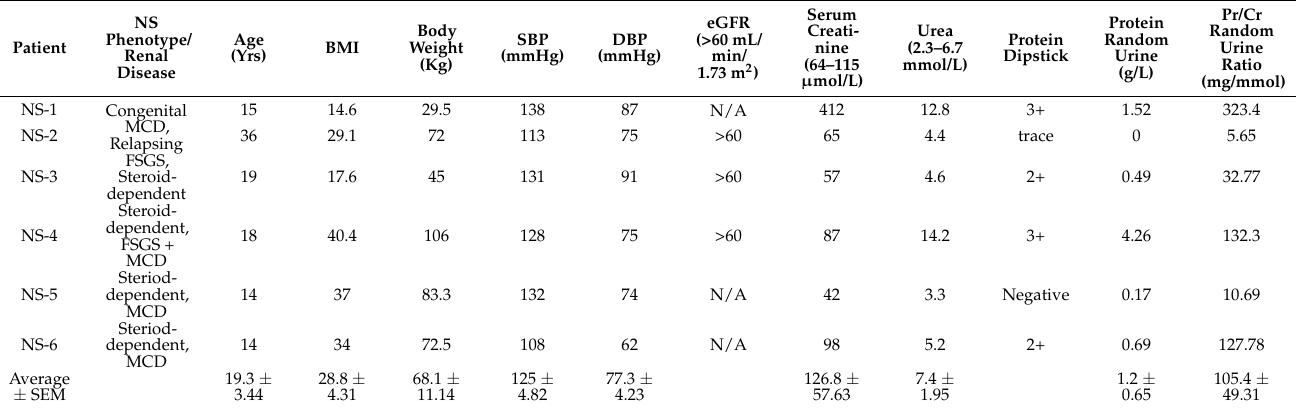
Table 1. Clinical characteristics of NS